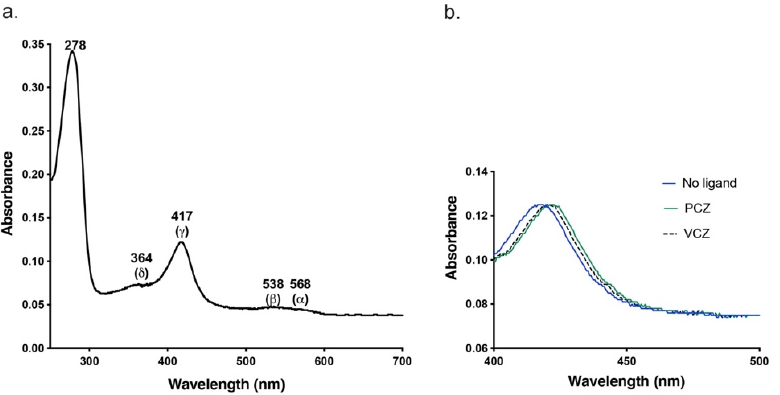
Figure 4. ( a ) Absolute absorbance spectrum of ligand-free SEC-purified CnCYP51-6×His. ( b ) The Soret peak of Ni-NTA affinity- and SEC-purified CnCYP51-6×His with PCZ, VCZ or no ligand.